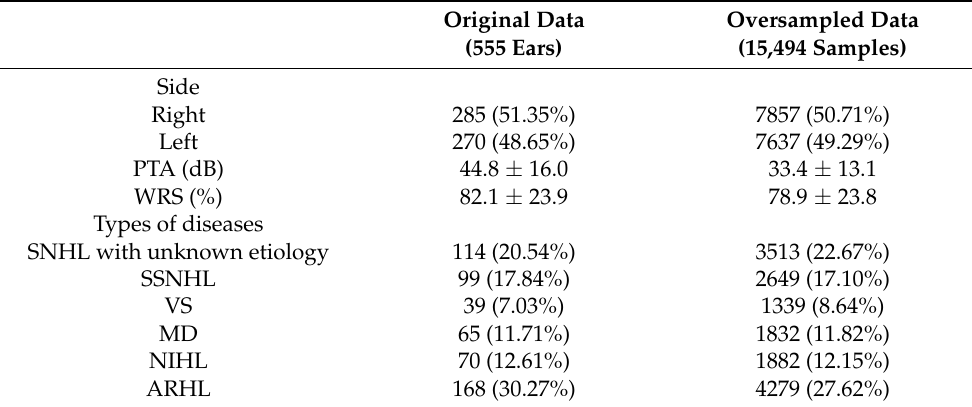
the oversampled data.